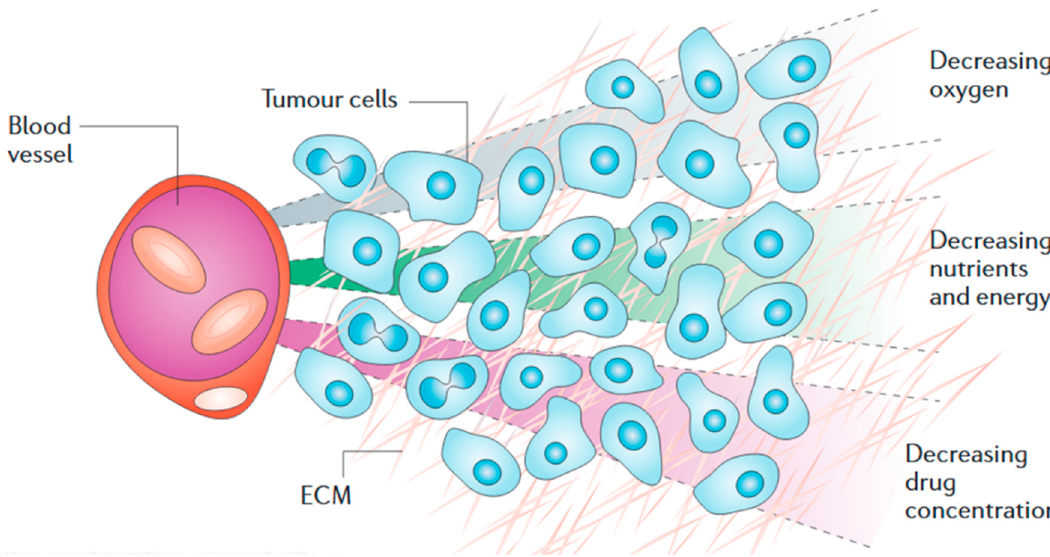
Figure 1. Schematic of the solid tumour environment. As distance from a blood vessel increases, the supply of oxygen, nutrients, and drug concentration becomes limited, leading to hypoxic, starved, and drug-resistant populations of tumour cells (ECM—extracellular matrix). Reprinted by permission from Springer Nature, Nature Reviews Cancer